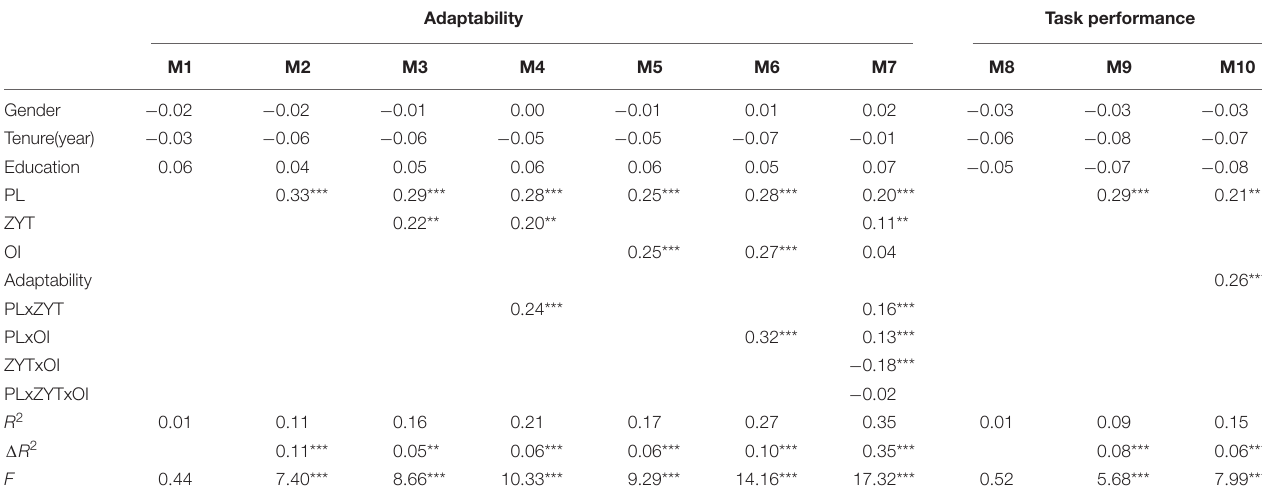
TABLE 4 | Analysis of